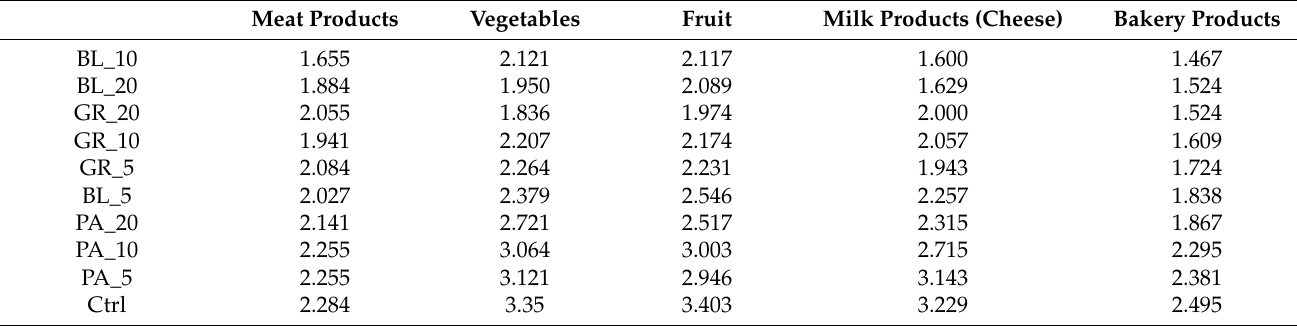
Table 5. Adjusted mean scores of the probability of purchasing a certain commodity in an edible coating. Meat Products Vegetables Fruit Milk Products (Cheese) Bakery Products